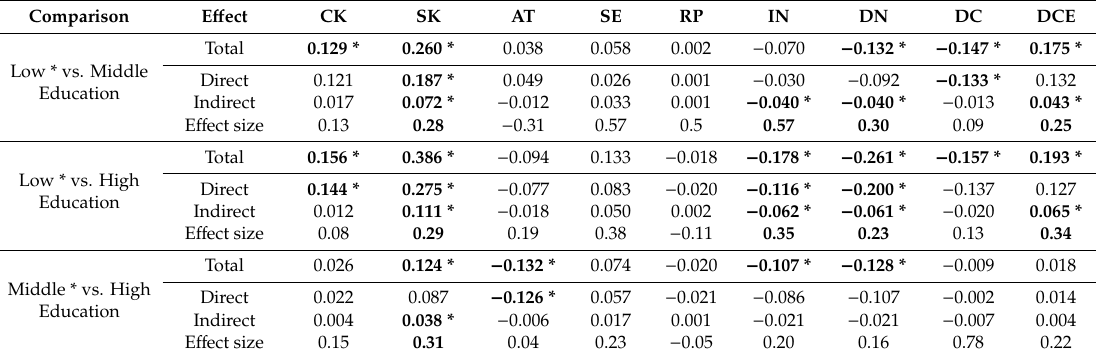
Table 3. Standardized total, direct and total indirect: mediator Application .